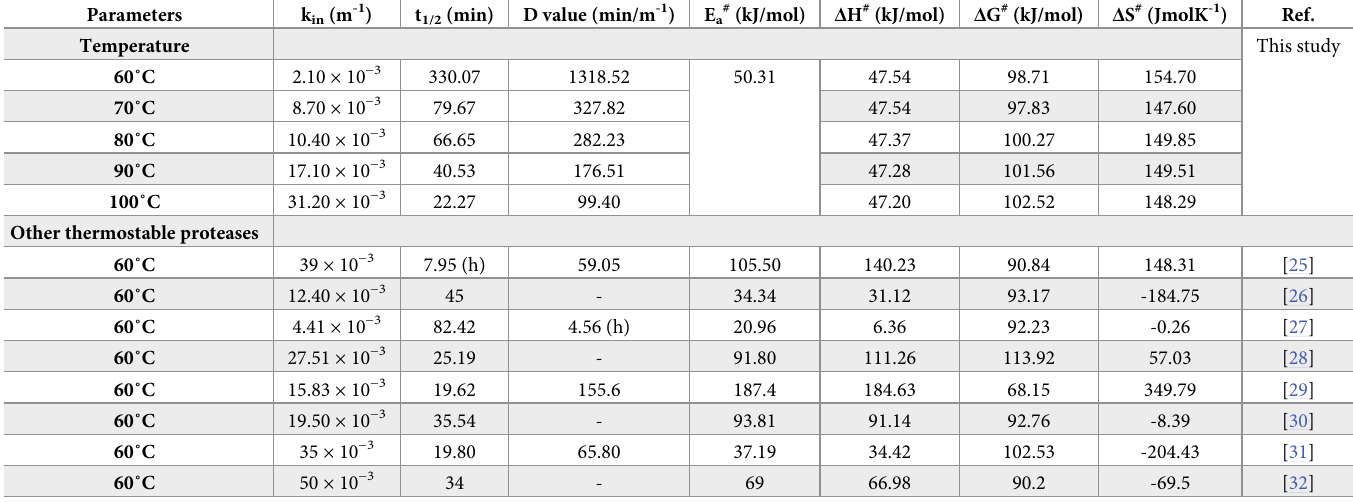
Table 3. Thermodynamic parameters for irreversible thermal inactivation of protease 1147. The parameters were measured after 120 min incubation at various tem- peratures, and the values obtained at 60˚C compared with other studied thermostable proteases. Parameters